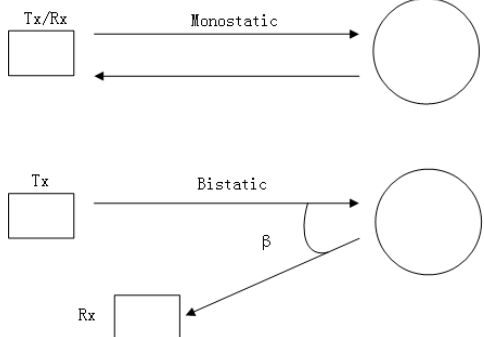
Figure 3. The monostatic and bistatic radar configurations.